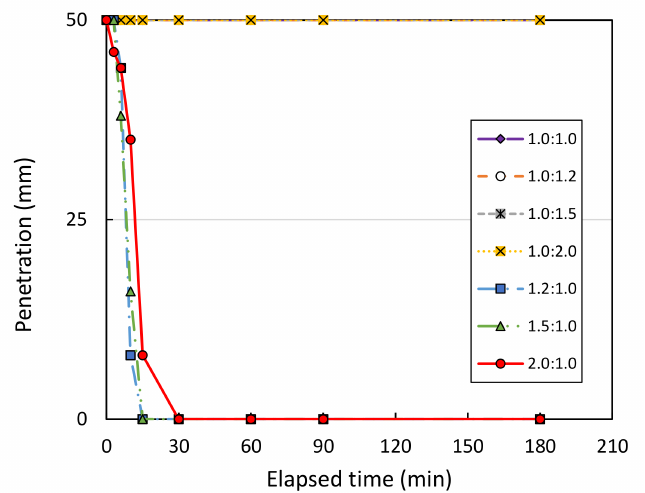
Figure 10. Penetration vs. elapsed time of Vicat needle testing for various ratios of NaOH to Na 2 SiO 3